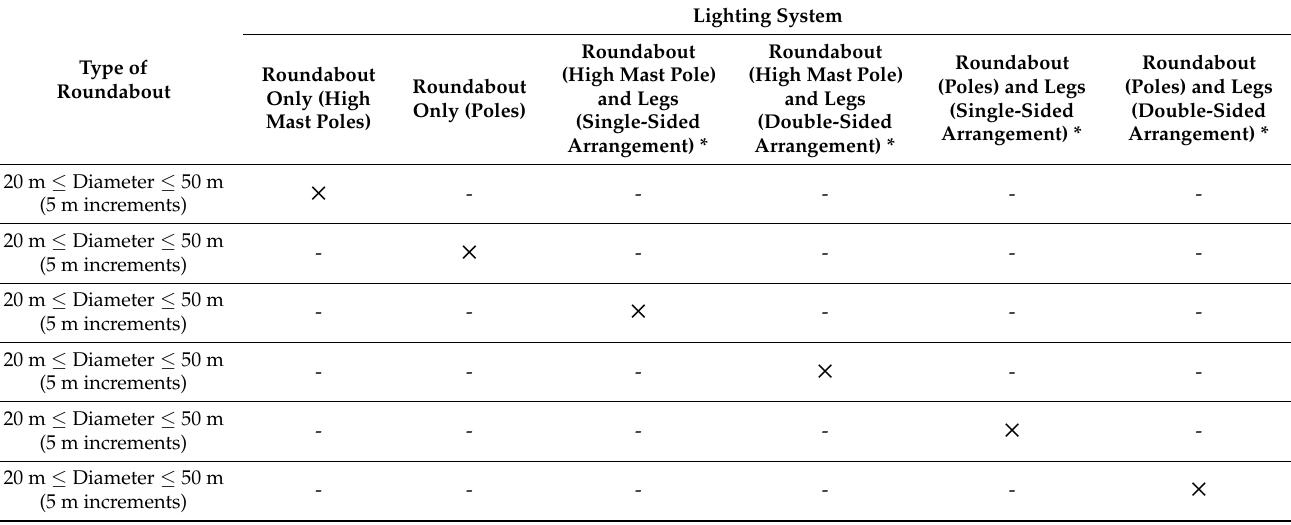
Table 2. Configurations chosen for the simulations (roundabouts and lighting